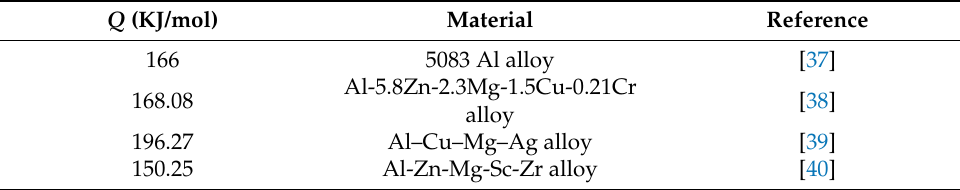
Table 5 . Thermal deformation activation energy of various materials. Table 5. Thermal deformation activation energy of various